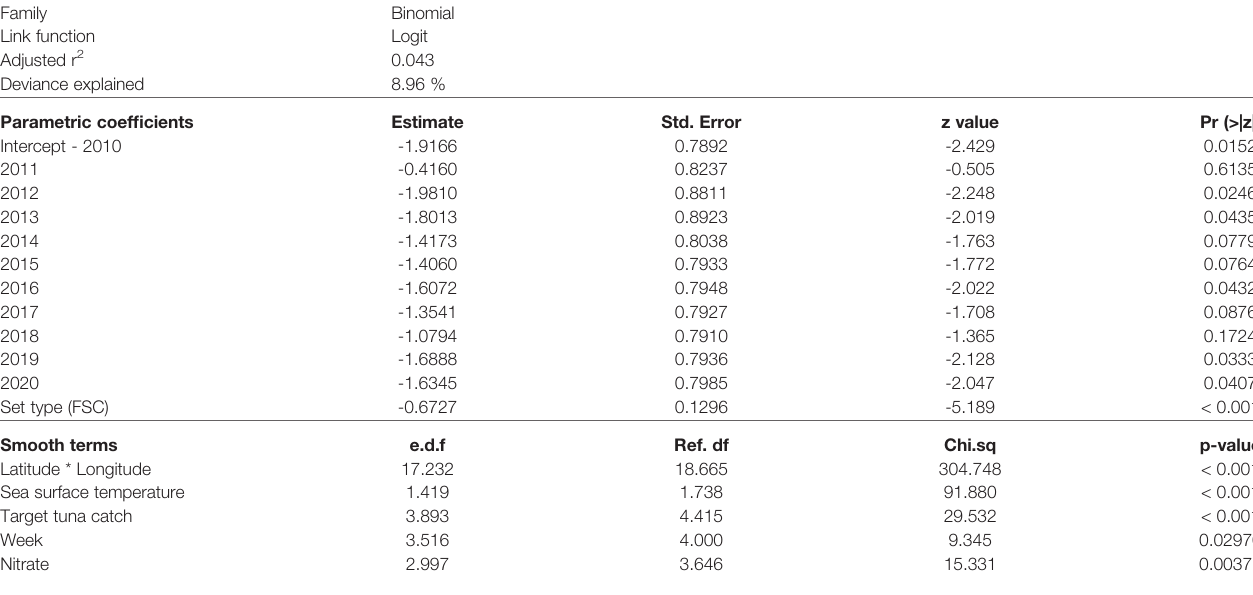
TABLE 3 | Summary results for the parametric coef fi cients and smooth terms of the fi nal GAM selected to model the probability of catching an oceanic whitetip shark in the western Indian Ocean over 2010-2020. Estimated degrees of freedom (e.d.f.).